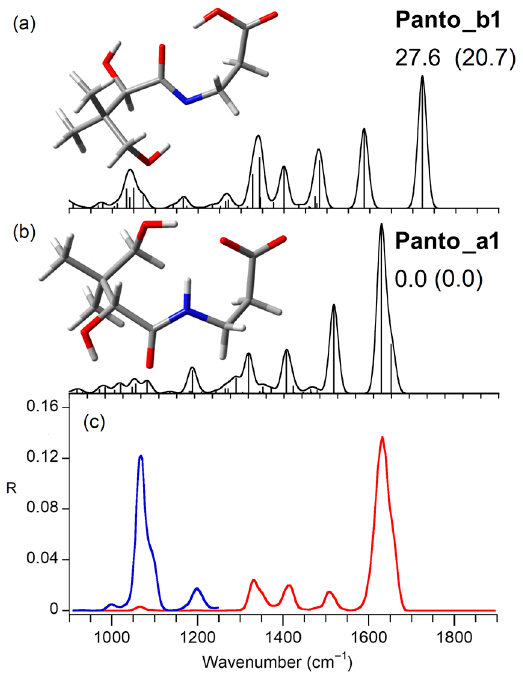
Figure 3. ( c ) Experimental IRMPD spectrum of deprotonated pantothenic acid [panto-H] − (bottom, colored profiles); ( b ) computed IR spectrum of Panto_a1 isomer; ( a ) computed IR spectrum of Panto_b1 isomer. IR spectra and optimized structures are obtained at the B3LYP level. Relative free energies at 298 K in kJ mol − 1 are computed at the B3LYP and MP2 level (in parentheses).